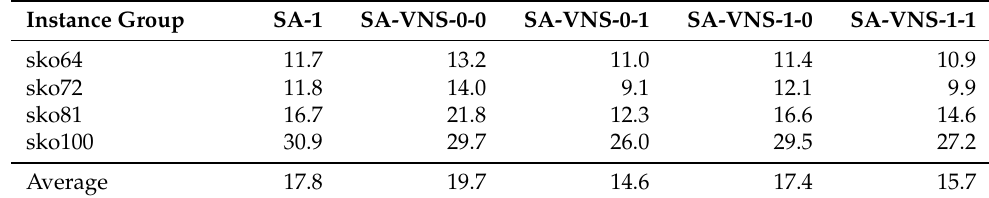
Table 3. Comparison of the average running time (in seconds) to the best solution in a run for the adapted sko instances (the time is averaged over all runs and all instances of the same size).